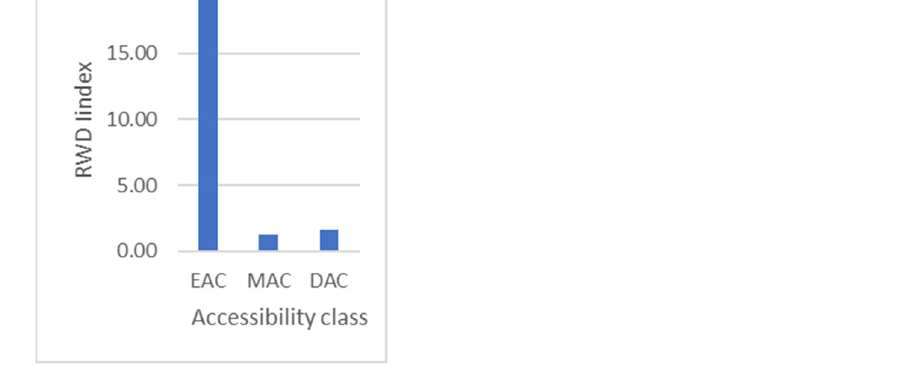
Figure 2. RWD index (CWD volume/standing volume) in the accessibility classes. Table 3. Percentage distribution of deadwood volume by decay class in each accessibility